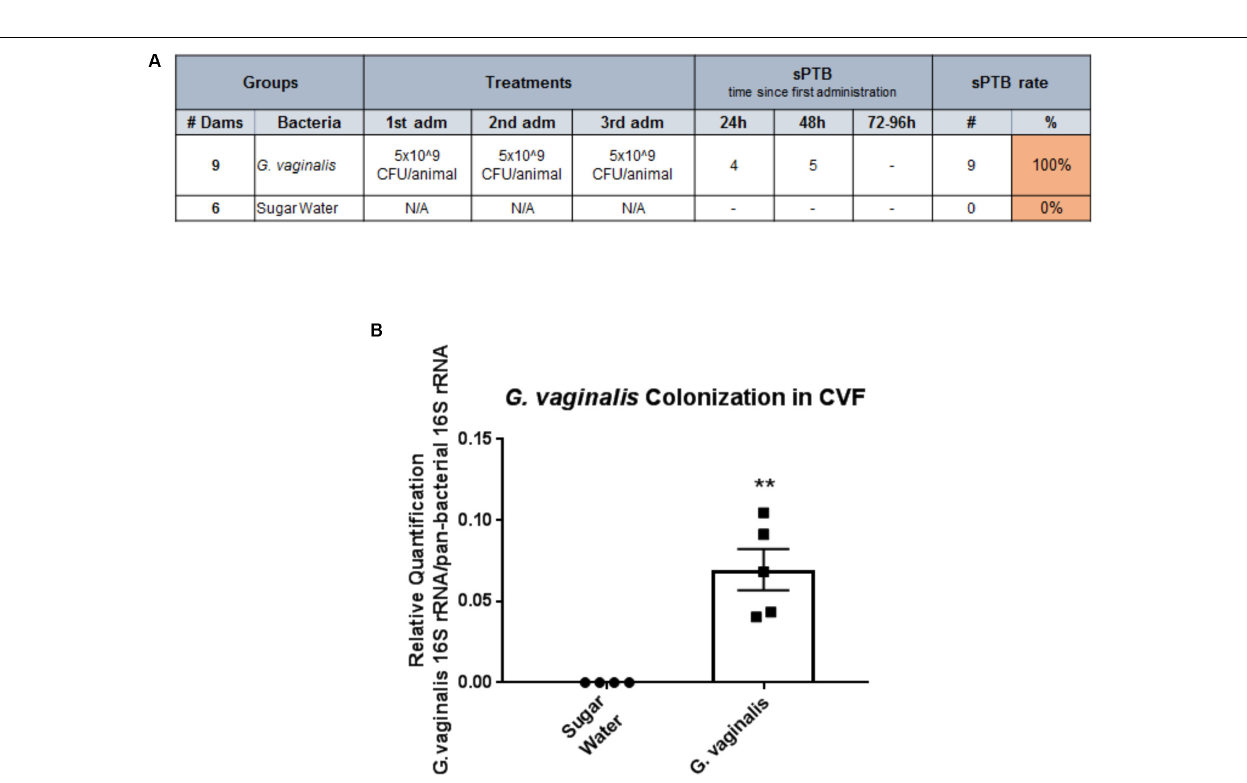
FIGURE 7 | Intravaginal inoculation of G. vaginalis results in PTB and colonization of the cervicovaginal space. (A) G. vaginalis (5 × 10 9 CFU/animal) was inoculated intravaginally into timed pregnant C57/B6 mice on embryonic day E13, E14, and E15. Sugar water inoculated animals acted as controls. Animals were observed for PTB daily until term. Table shows the dose of G. vaginalis inoculation at each administration, the number of dams delivering preterm on each day following the first inoculation, and the PTB percentage. (B) . G. vaginalis (5 × 10 9 CFU/animal) was inoculated intravaginally into timed pregnant C57/B6 mice on E13. Animals were sacrificed 24 h after inoculation. Cervicovaginal fluid (CVF) was collected for gDNA isolation and measurement of the 16S gene of G. vaginalis by QPCR. Sugar water inoculated animals acted as controls. Values are mean ± SEM. ∗∗ p <